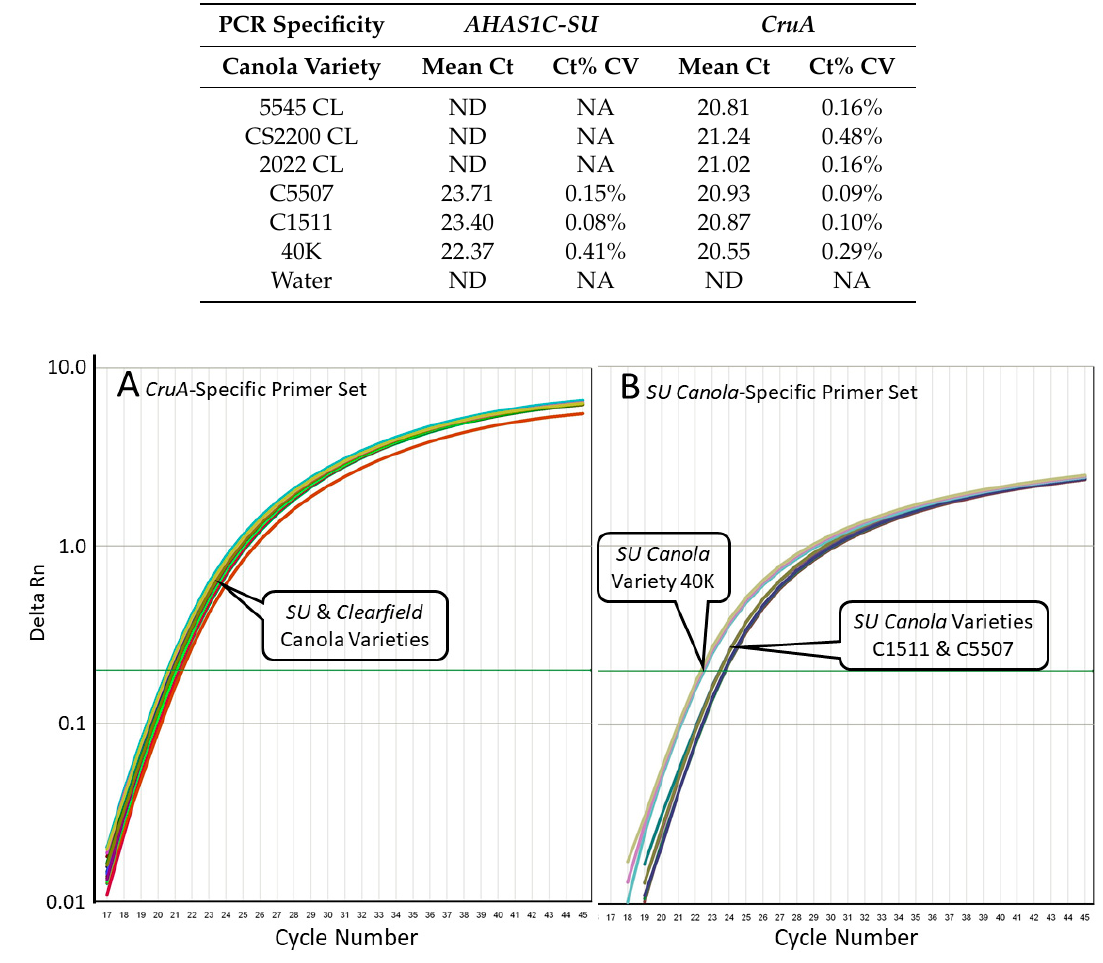
Figure 4. Quantitative PCR amplification curves for the results shown in Table 2, with primers specific for the CruA gene (Panel ( A )) or with primers specific for the SU canola AHAS1C-SU gene (Panel ( B )). In Panel ( B ), amplification occurred only with the SU canola varieties 40K, C1511, and C5507, while in Panel ( A ), amplification also occurred with the Clearfield canola varieties.